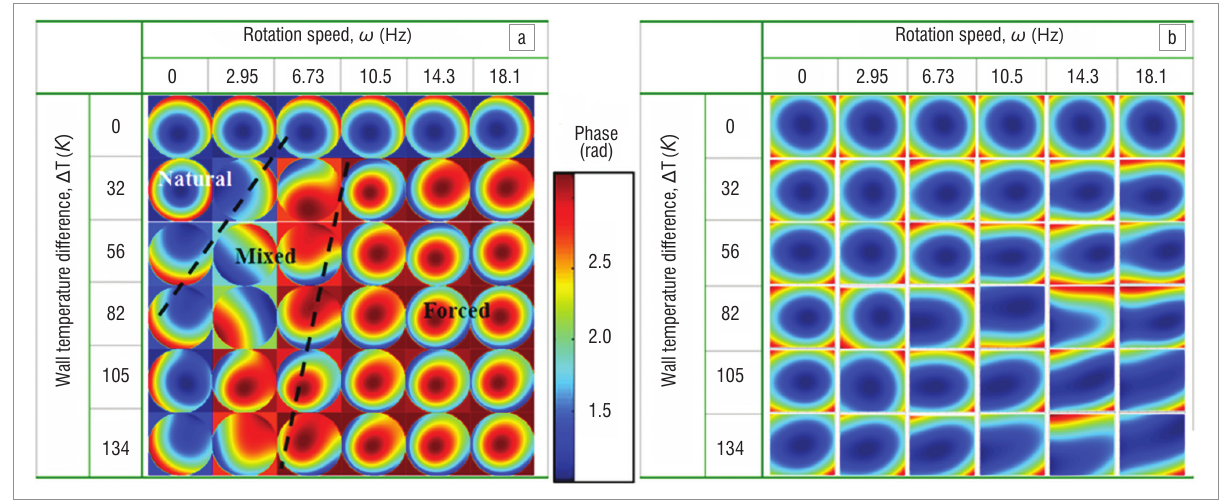
Figure 6: Average phase maps produced by the spinning pipe gas lens (a) axis and (b) boundary layer. The images on the left are apertured because these were focused beams. The images on the right were not apertured to show the effect of tilt on the phase.